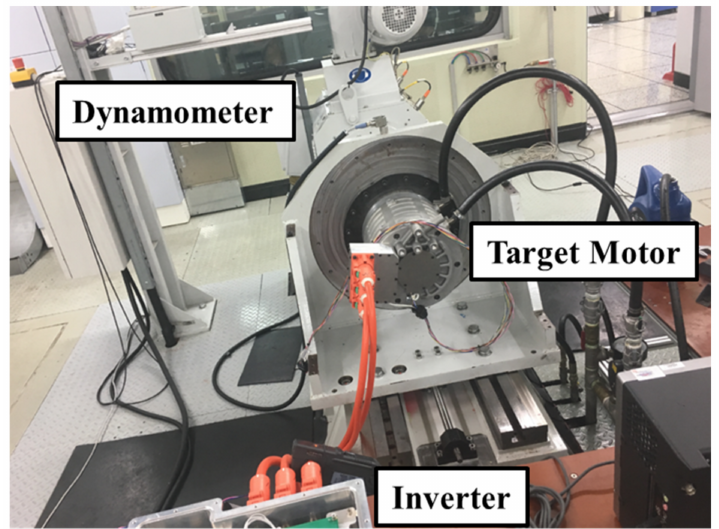
Figure 19. The experimental